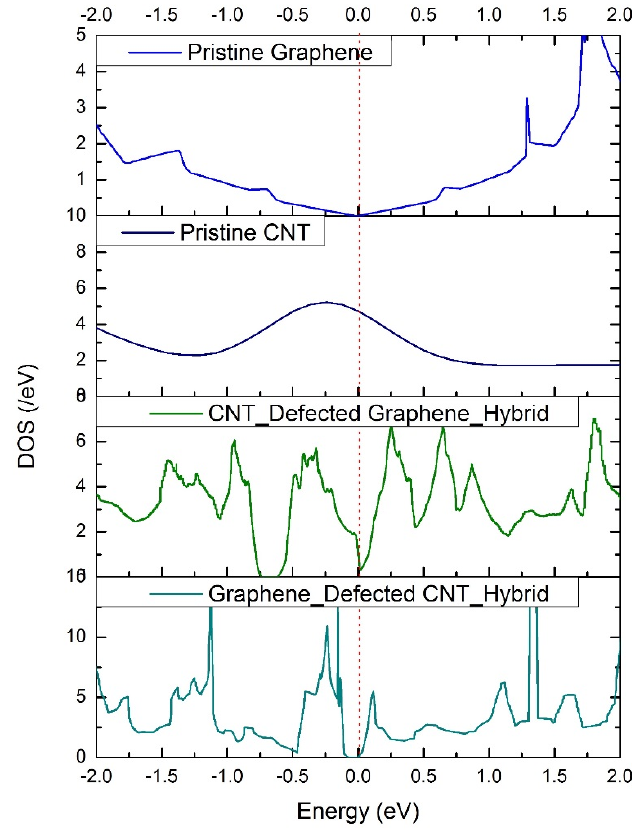
Figure 7. Density − of − states (DOS) profiles of the pristine graphene sheet, pristine CNT, defective graphene + pristine CNT hybrid, and pristine graphene + defective CNT hybrid.